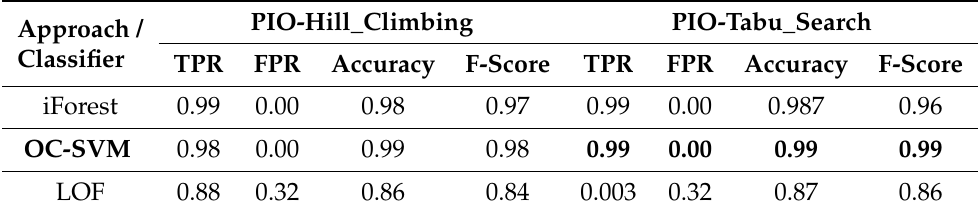
Table 8. The evaluation results for LS_PIO using DNS_UNSW-NB15 dataset. Approach